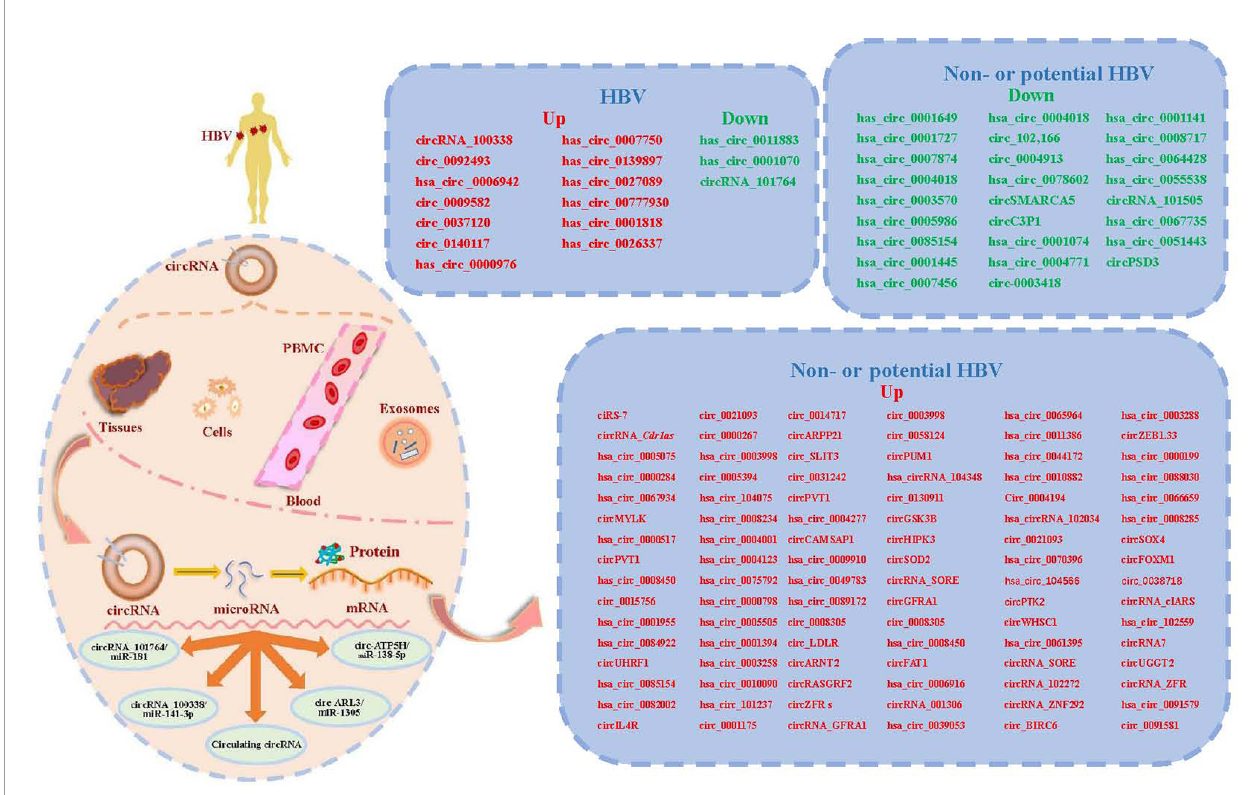
FIGURE 1 | A summary diagram of circular RNAs (circRNAs) involved in circRNA-microRNA (miRNAs)-mRNA axis in hepatocellular carcinoma (HCC) with or without hepatitis B virus (HBV). CircRNAs can be found in liver tissues, cells, serum, plasma, peripheral blood mononuclear cells (PMBC) and exosomes. Most circRNAs can act as miRNA sponges or sequesters. CircRNAs may function as sponges or decoys for proteins and thereby regulate their activity. At least four reported circRNA/ miRNA regulatory axes and several circulating circRNAs might contribute to the development of chronic hepatitis B (CHB) related HCC. We list the validated circRNAs on the right of this fi